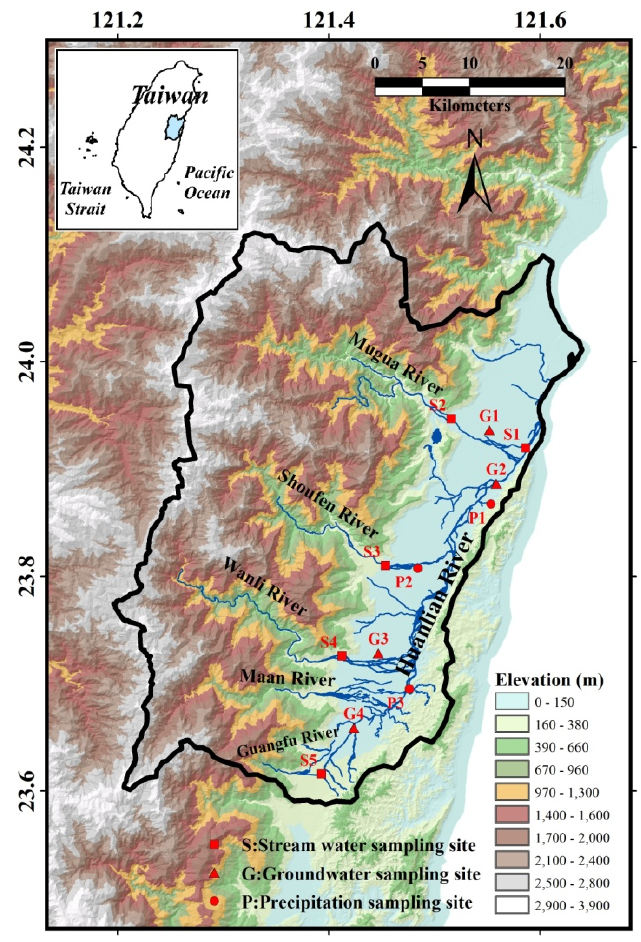
Figure 1. The location of the study region. Precipitation sampling sites (circles), river water (squares), and groundwater (triangles) samples are